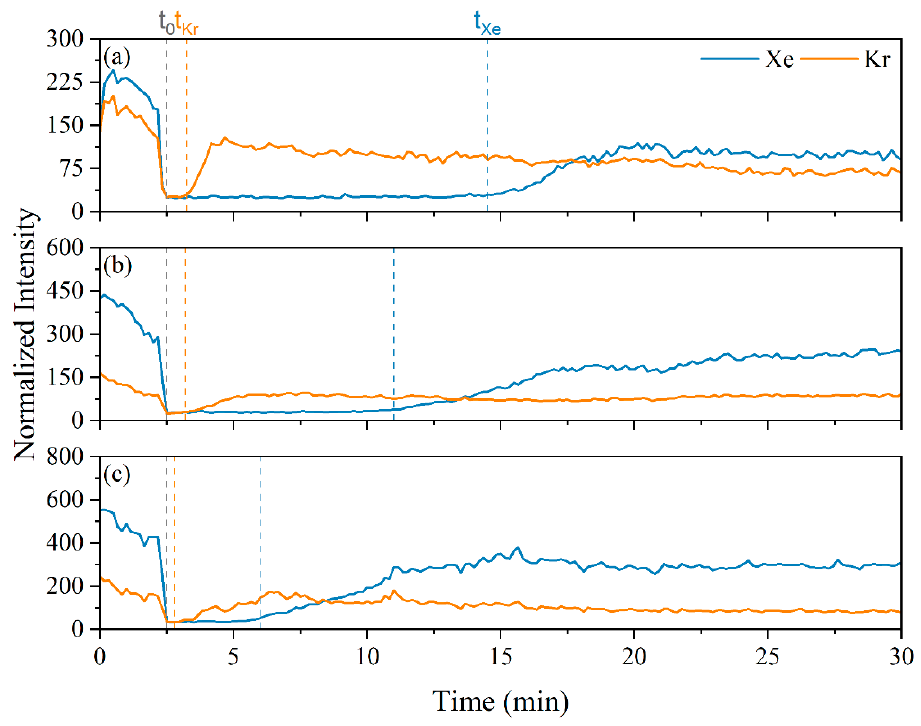
Figure 7. Xe and Kr breakthrough curves for various mixture ratios: ( a ) 1000 ppm Xe, 1000 ppm Kr, ( b ) 2000 ppm Xe, 1000 ppm Kr, and ( c ) 3000 ppm Xe, 1000 ppm Kr.